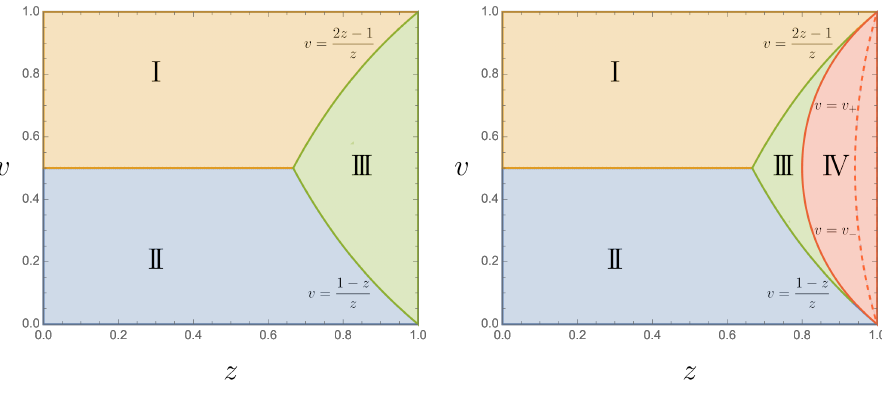
Figure 1 . Two-body phase space for 1-jettiness, τ jt,kt with jettiness/anti- k T axis (left) and τ ct with Centauro axis (right). 1-jettiness takes the same expression in first three regions while the fourth region is only for τ ct . The bound of fourth region for jet radius R = 1 and 2 is shown in red dashed and red solid,